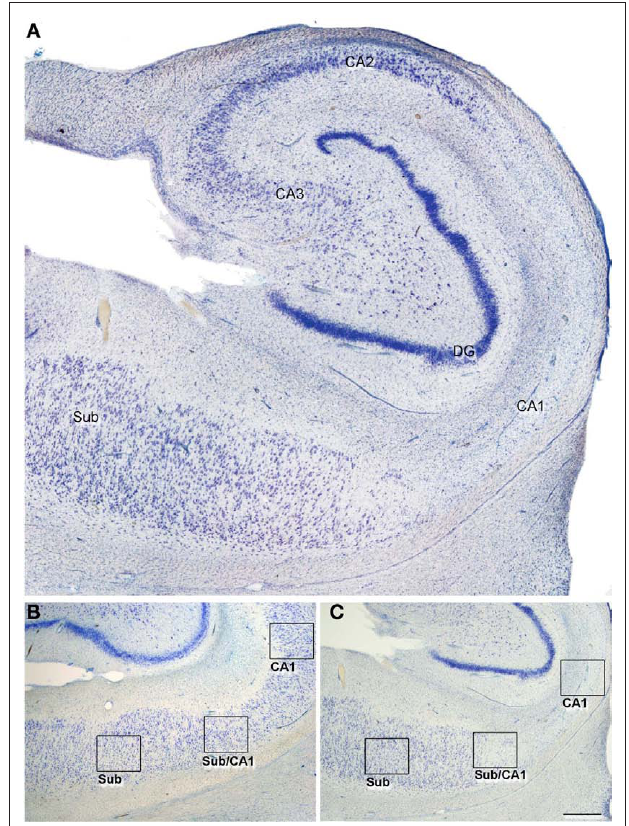
formation. In all cases, the tissue used corresponded to a similar level. (B,C) Photomicrographs of Nissl-stained sections of a non-sclerotic (B) and a sclerotic hippocampal formation (C) illustrating the regions examined in the present study (indicated by boxes). CA1–3: cornu ammonis fields; DG, dentate gyrus; Sub, subiculum, Sub/CA1: transitional subiculum/CA1 region. Scale bar [in (B) ]: 500 μm in (A) , 1000 μm in (B,C)